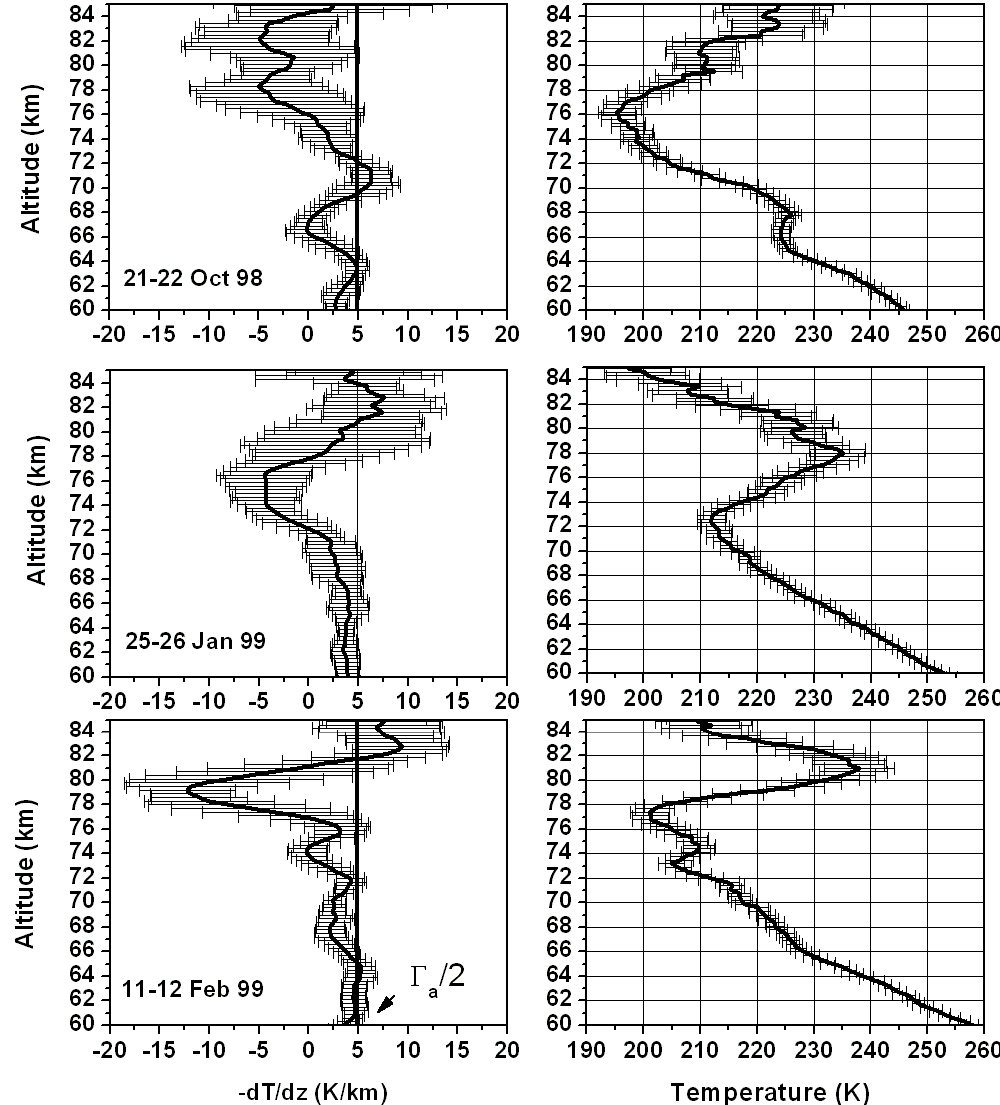
Fig. 6. The altitude variations of local environmental lapse rate (left panels) and mean temperature (right panels) over Gadanki. The uncertainties in the estimations are shown as error